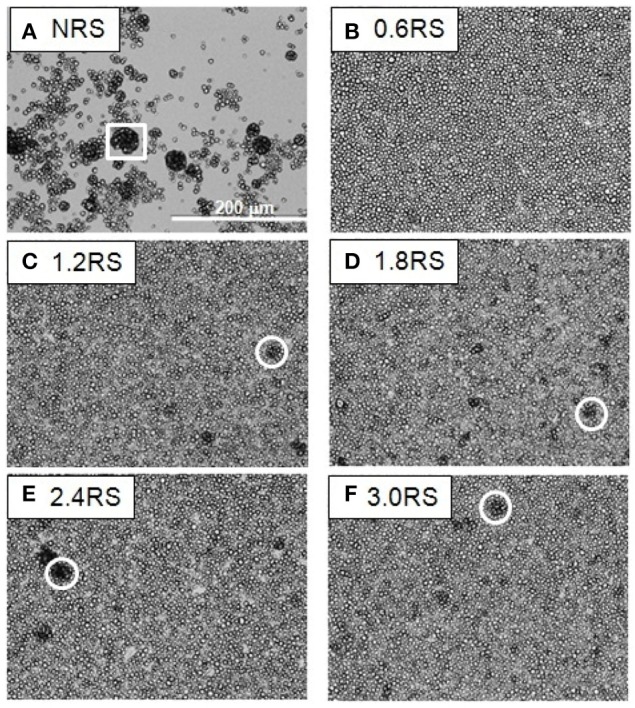
Optical microscope images of films of native and OSA modified starch particles compressed to ∏ = 15 mN/m at air/water interfaces. The white square shows an example of the large aggregates formed by the NRS particles. The white circles show examples of dark patches of closely packed OSA modified particles or aggregates in the films.